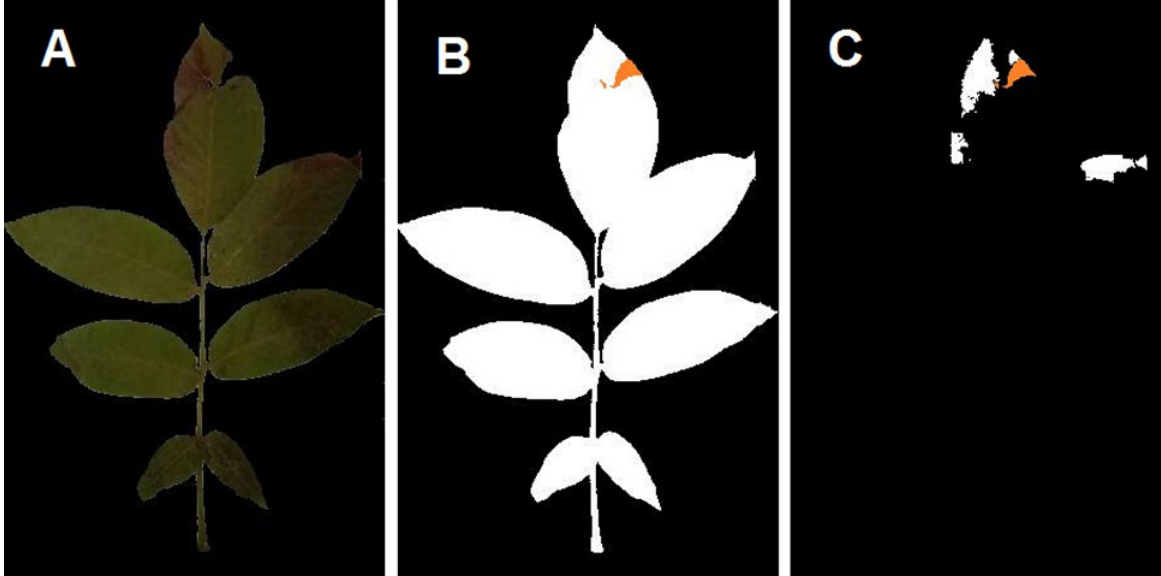
Figure 2. The original leaf image with omitted background (A), the binary mask of the leaf image (white spaces) with holes/losses filled (orange spaces) (B), and the infected area based on image segmentation function (white and orange spaces)